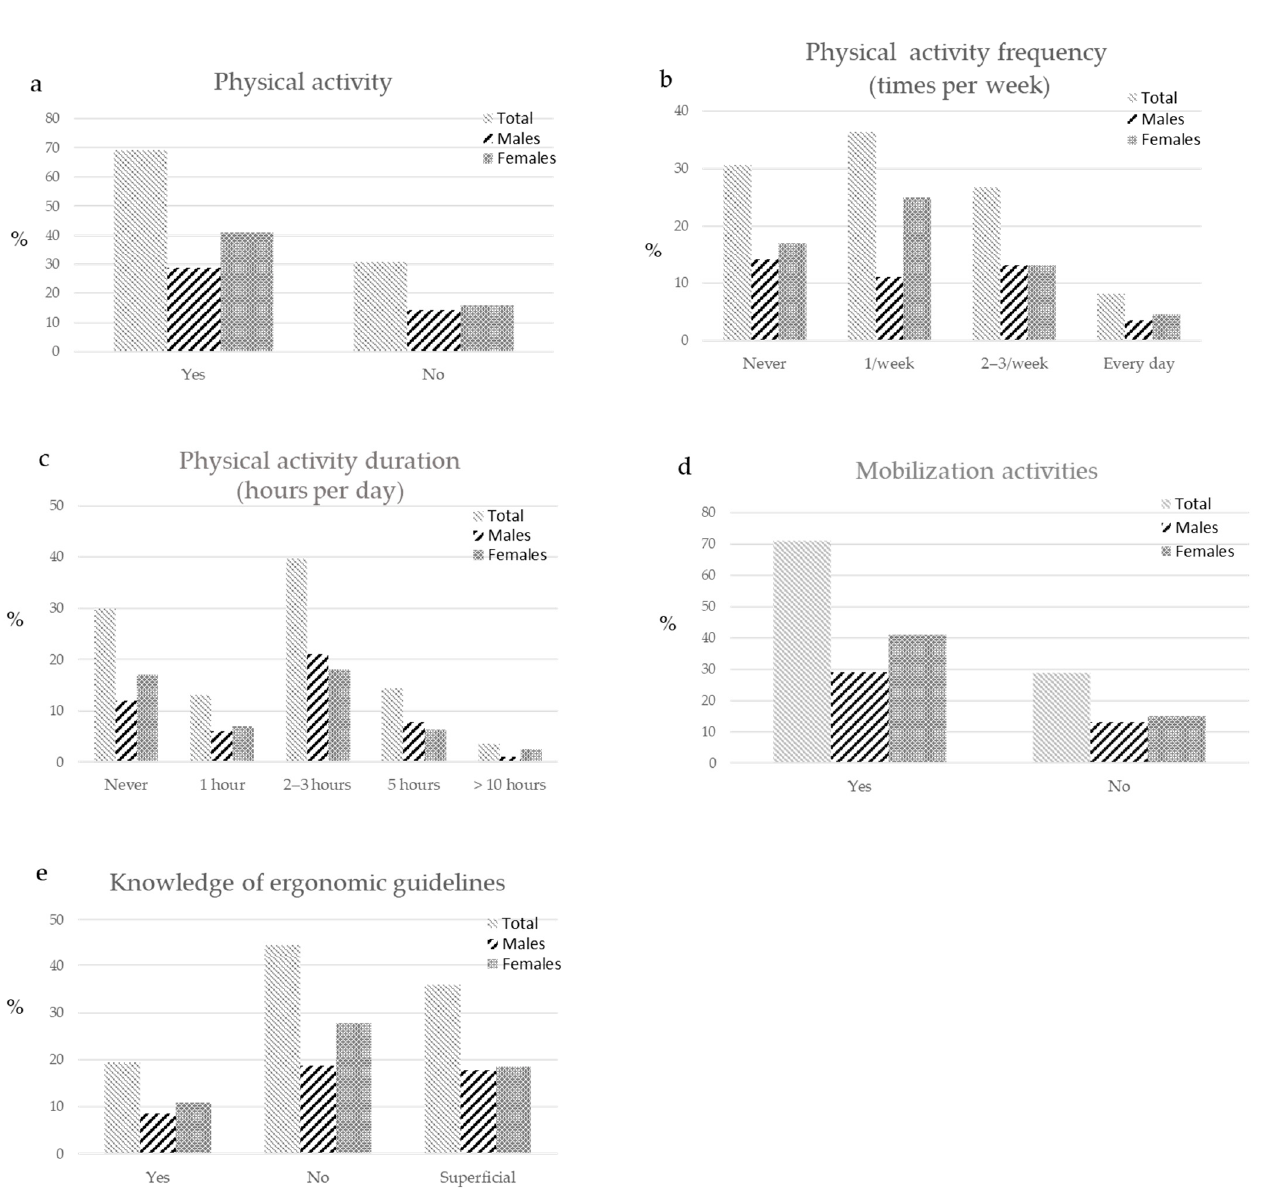
Figure 3. Lifestyle and knowledge of ergonomics. Practice of physical activity, including frequency and duration, mobilization activities and ergonomic knowledge of surveyed operators, expressed in percentages. ( a ) The image shows that a very low percentage of operators (approximately 30%) did not practice physical activity. The physical activity was performed mostly ( b ) 1 time a week and ( c ) 2–3 h per week. ( d ) A high number of dental professionals performed some mobilization activities (approximately 70%). ( e ) Few operators (only 20%) declared a complete knowledge of the ergonomic guidelines, a total 35% had a superficial knowledge and more than 40% of surveyed operators did not know the guidelines.